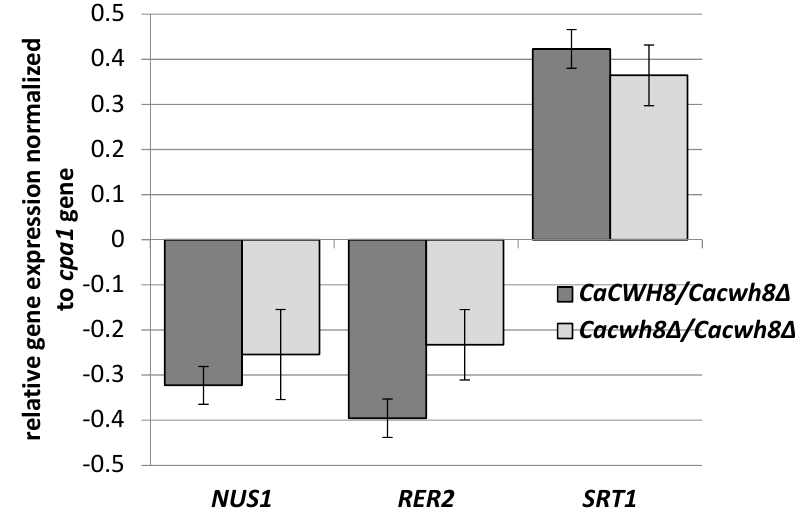
Figure 5. Relative transcript levels of NUS1 , RER2 , and SRT1 genes in C. albicans CaCWH8 mutants compared to the wild type strain.